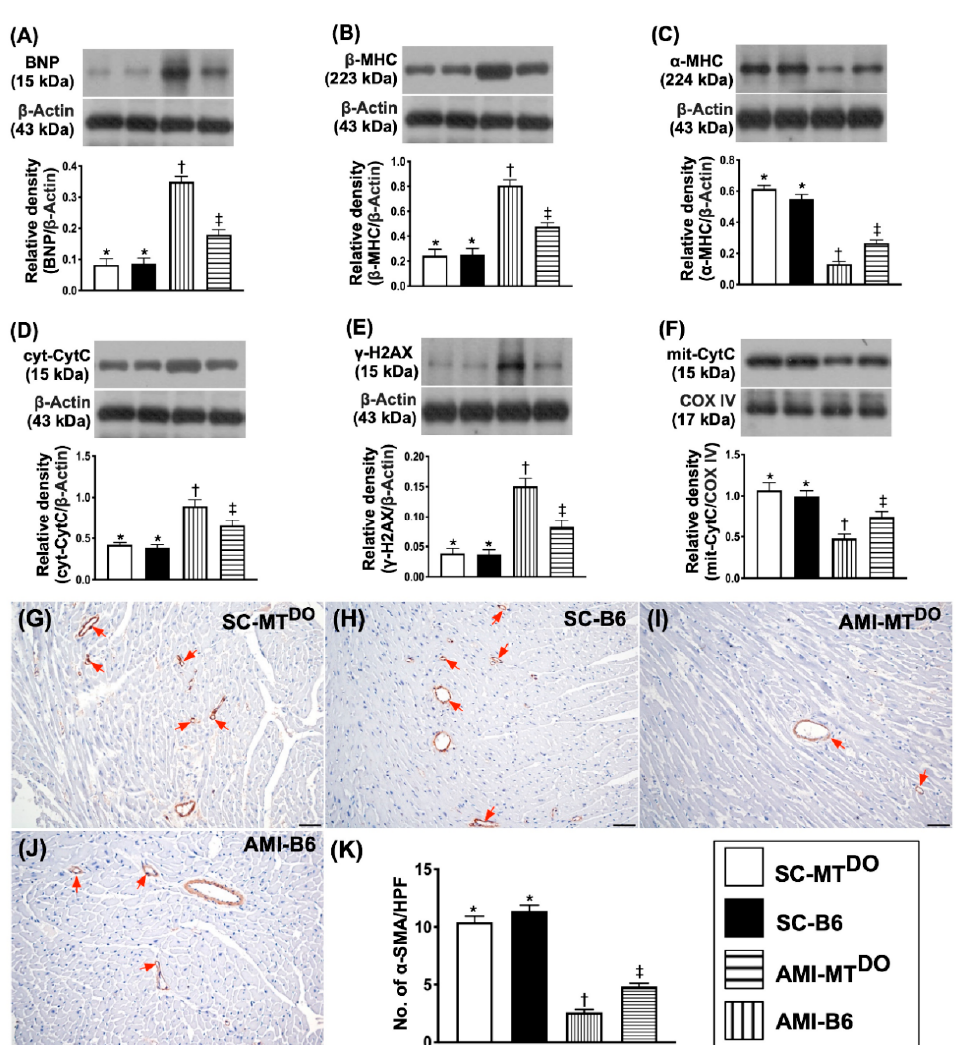
Figure 5. Protein expression of heart failure / pressure overload and mitochondrial / DNA damage biomarkers in LV myocardium by 60 days after the AMI procedure. ( A ) Protein expression of brain natriuretic peptide (BNP), * vs. other groups with di ff erent symbols ( † , ‡ ), p < 0.0001. ( B ) Protein expression of β -myosin heavy chain (MHC) protein expression, * vs. other groups with di ff erent symbols ( † , ‡ ), p < 0.0001. ( C ) Protein expression of α -MHC, * vs. other groups with di ff erent symbols ( † , ‡ ), p < 0.0001. ( D ) Protein expression of cytosolic cytochrome C (cyt-CytoC), * vs. other groups with di ff erent symbols ( † , ‡ ), p < 0.0001. ( E ) Protein expression of γ -H2AX, * vs. other groups with di ff erent symbols ( † , ‡ ), p < 0.0001. ( F ) Protein expression of mitochondrial cytochrome C (mit-CytoC), * vs. other groups with di ff erent symbols ( † , ‡ ), p < 0.0001. ( G–J ) Illustrating the microscopic finding (100 − ) for identification of small vessel density (red arrows). ( K ) Analytical result of the number of small vessels (i.e., diameter of the vessel ≤ 25 µ M), * vs. other groups with di ff erent symbols ( † , ‡ ), p < 0.0001. The scale bars in the right lower corner represent 100 µ m. All statistical analyses were performed by one-way ANOVA, followed by Bonferroni multiple comparison post hoc test ( n = 6 for each group). Symbols (*, † , ‡ ) indicate significance (at 0.05 level). SC = sham-operated control; MT DO = double knock out of matrix metalloproteinase (MMP)-9 and tissue plasminogen (tPA) in mouse; B6 (i.e., wild type) = C57BL / 6 mice. LV = left ventricular; AMI = acute myocardial